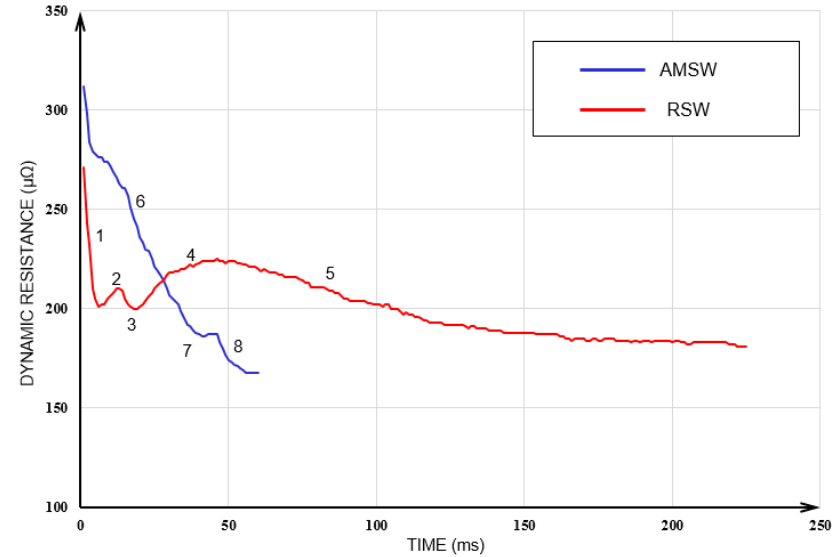
Figure 6. Dynamic resistance of the spot welding process using additive manufacturing (AMSW) and the resistance spot welding (RSW) process on zinc-coated sheets (numbers description in the text).